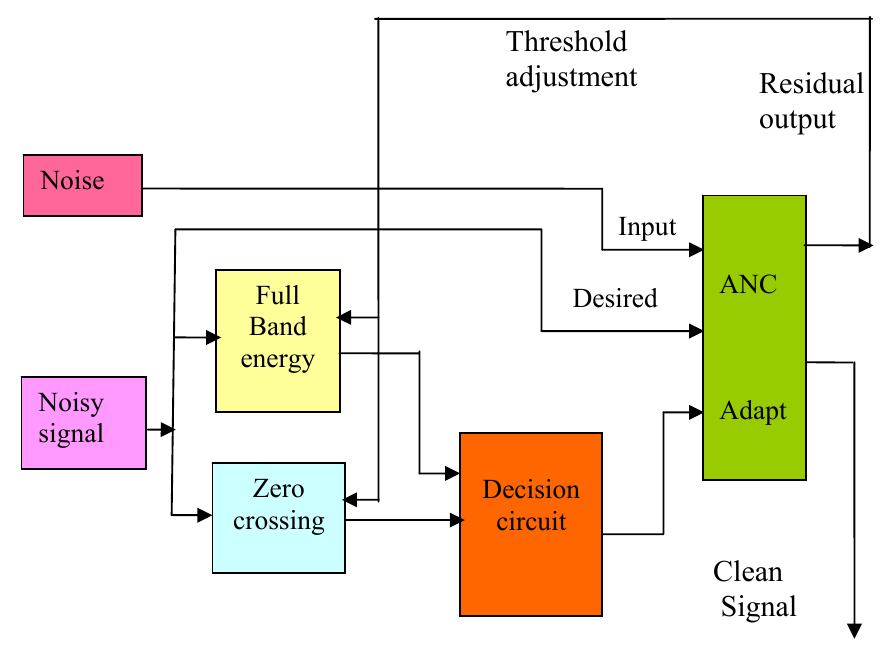
Figure 8. Thresholds adjustment using residual output